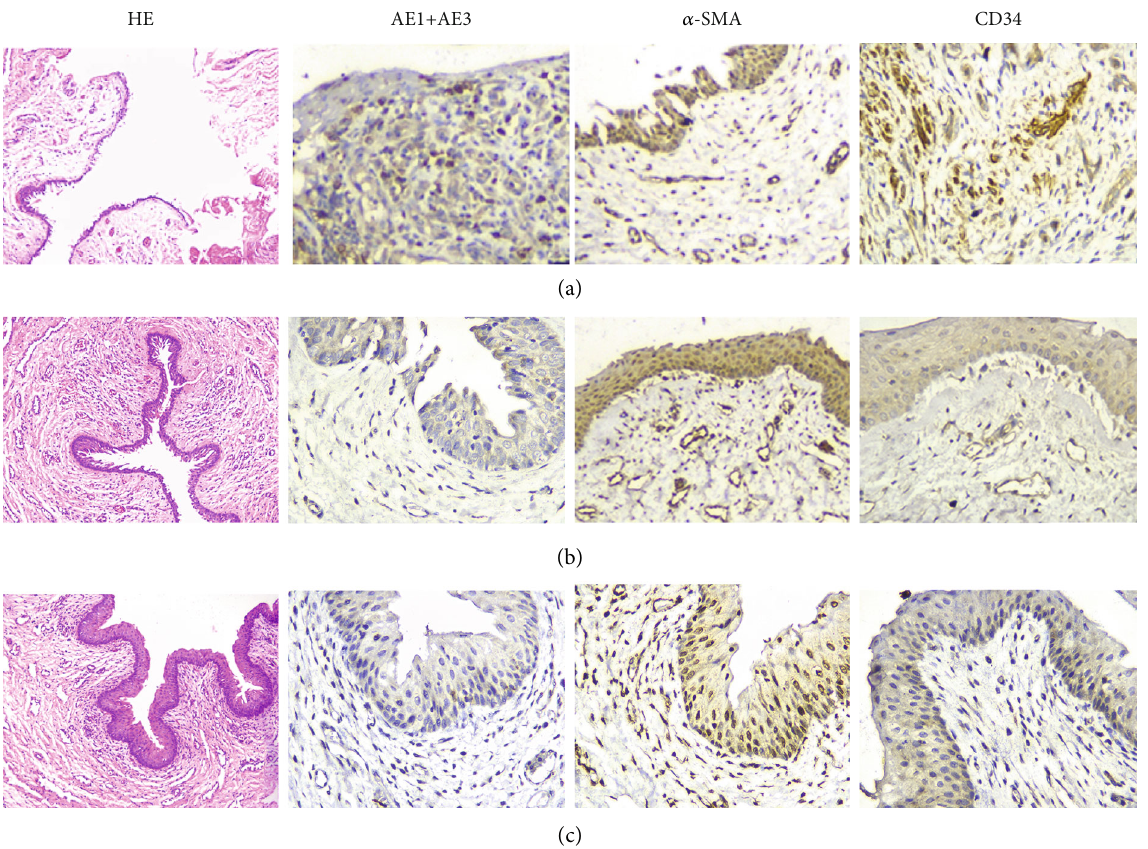
Figure 7: Histological analysis of reconstructed urethra: (a) the control group; (b) the experimental group; (c) normal urethral tissue (HE × 100, immunohistochemistry ×